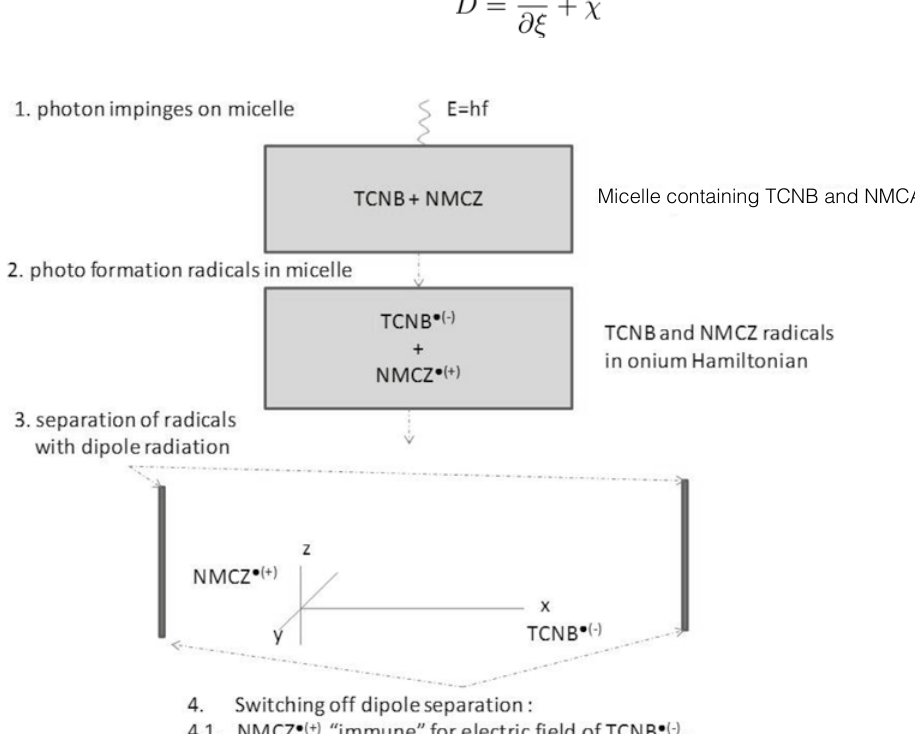
Figure Appendix A.1 . Set-up of the experiment described in the main body of paper. The charged radical molecules are generated by light in a micelle. Subsequently they are separated and a transformation of the mesoscopic inter-molecular wave function such that the NMCZ(+) and the TCNB(-) are immune to each others Coulomb field at a mesoscopic